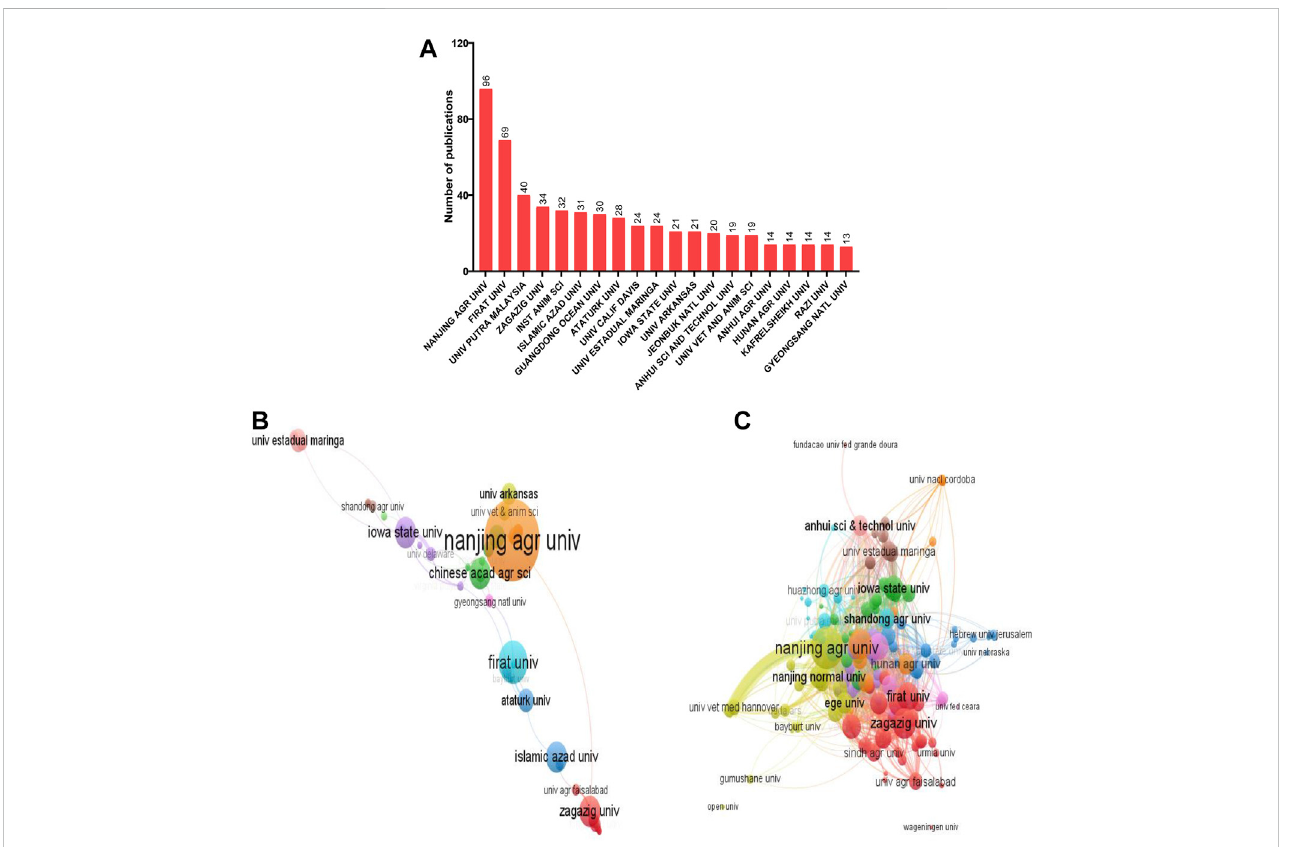
FIGURE 4 Analysis on the institutional contributions to research on heat stress in poultry. (A) Most relevant af fi liations. (B) Network visualization for co-authorship analysis of contributing institutions. (C) Network visualization for the citation analysis of contributing institutions. The larger the node, the greater the institutional contribution, and the thicker the line, the greater the link strength between the connected institutions.